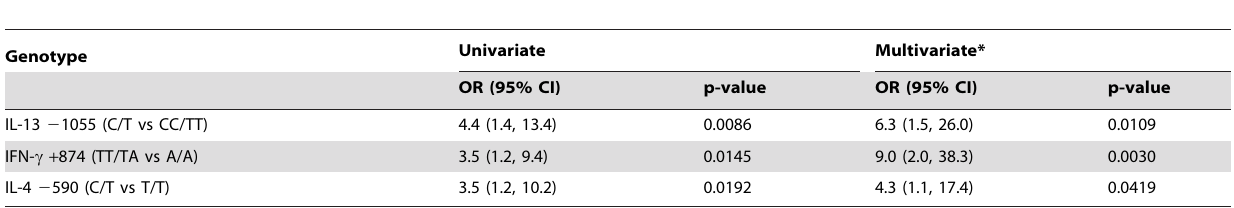
Table 2. Odds ratios for the associations between individual genotypes and resistance to reinfection by univariate and multivariate